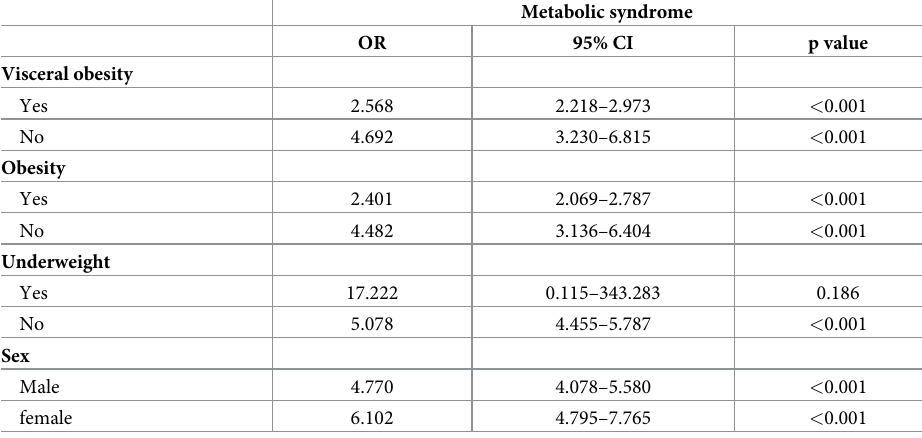
Table 3. Stratified association between metabolic syndrome and